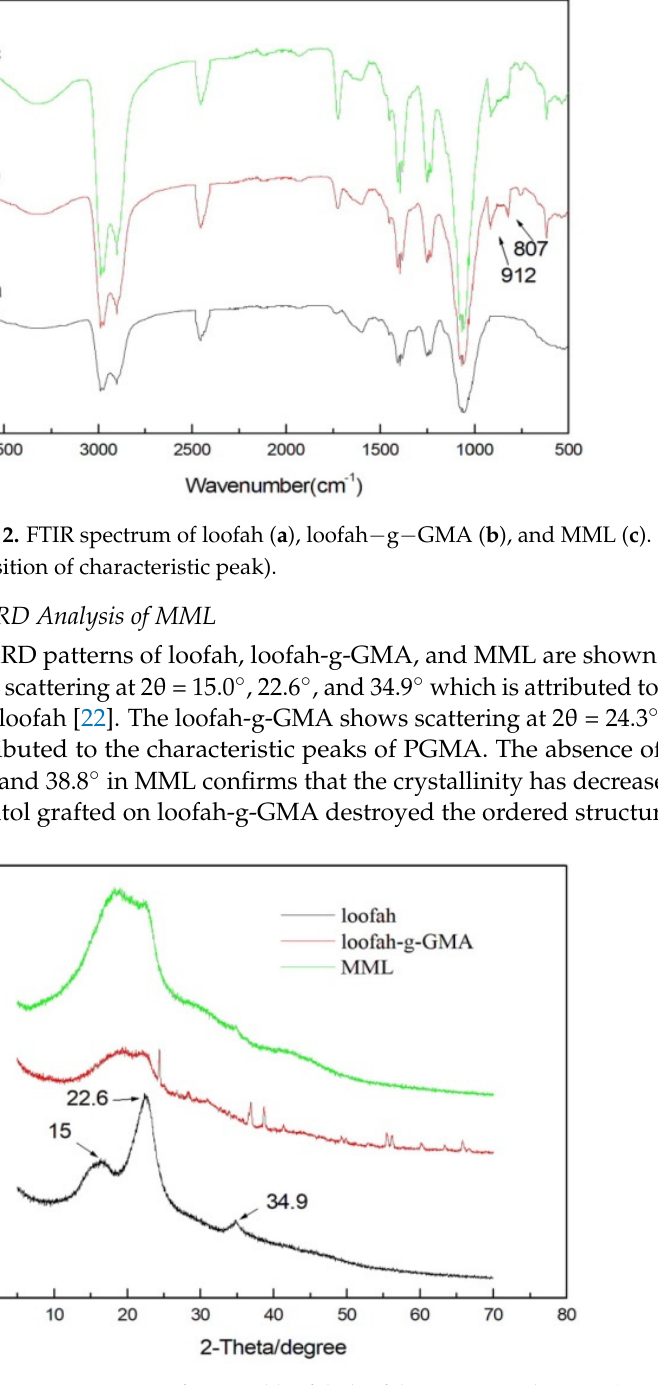
Figure 3. XRD patterns of original loofah, loofah-g-GMA and MML. ( Note: The arrows point to the position of the diffraction peak )